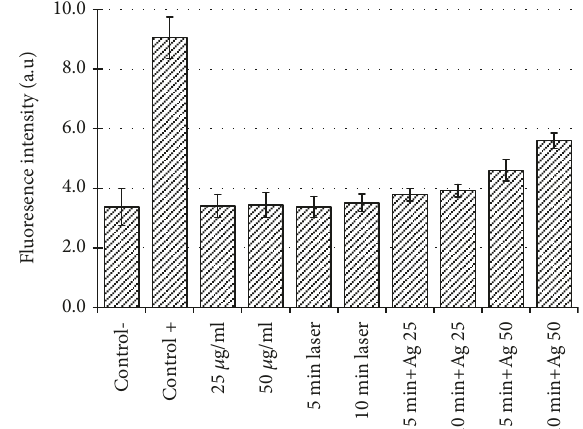
Figure 7: Relative fl uorescence intensity (with respect to H showing cellular ROS formation following treatment with laser irradiation (5 and 10 min), Ag-NPs (25 and 50 mg/ml), and photoirradiated Ag-NPs in S. aureus cells compared to negative and positive